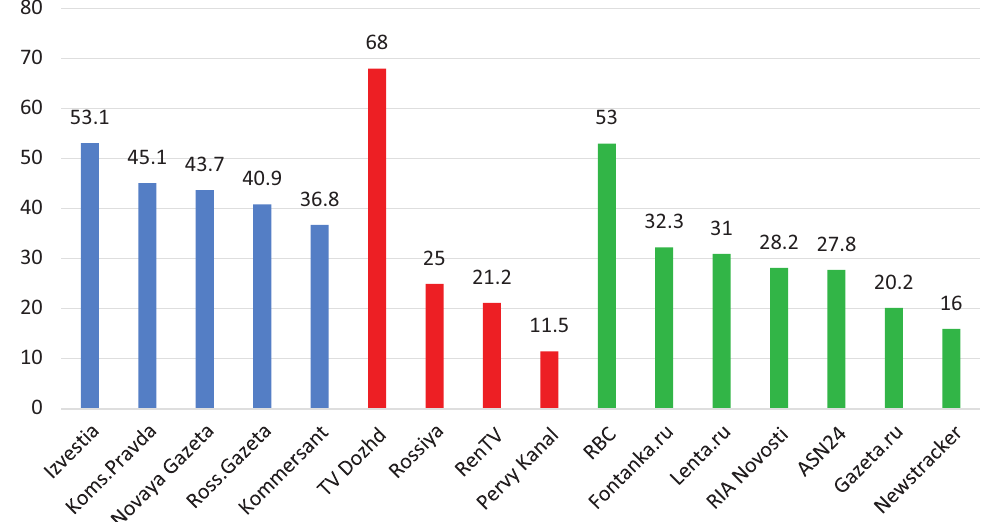
Figure 1. Percentages of publications on immigration that also discuss Covid‐19. Notes: Blue = newspapers; red = TV chan‐ nels; green = news portals and news agencies; Koms.Pravda = Komsomolskaya Pravda ; Ross.Gazeta = Rossiyskaya Gazeta